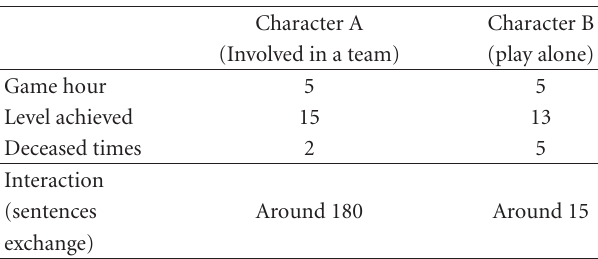
Table 2: A comparison of two players in a team and playing alone,